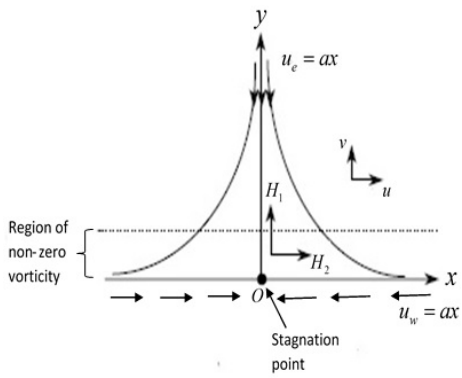
Figure 1. Physical model and coordinate system for the shrinking sheet.